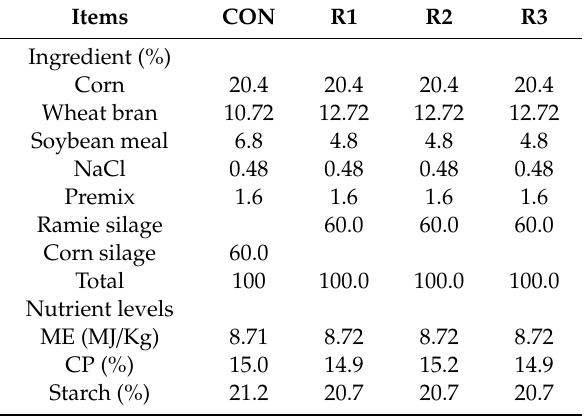
Table 1. Composition and nutrient levels of the experimental diet *.